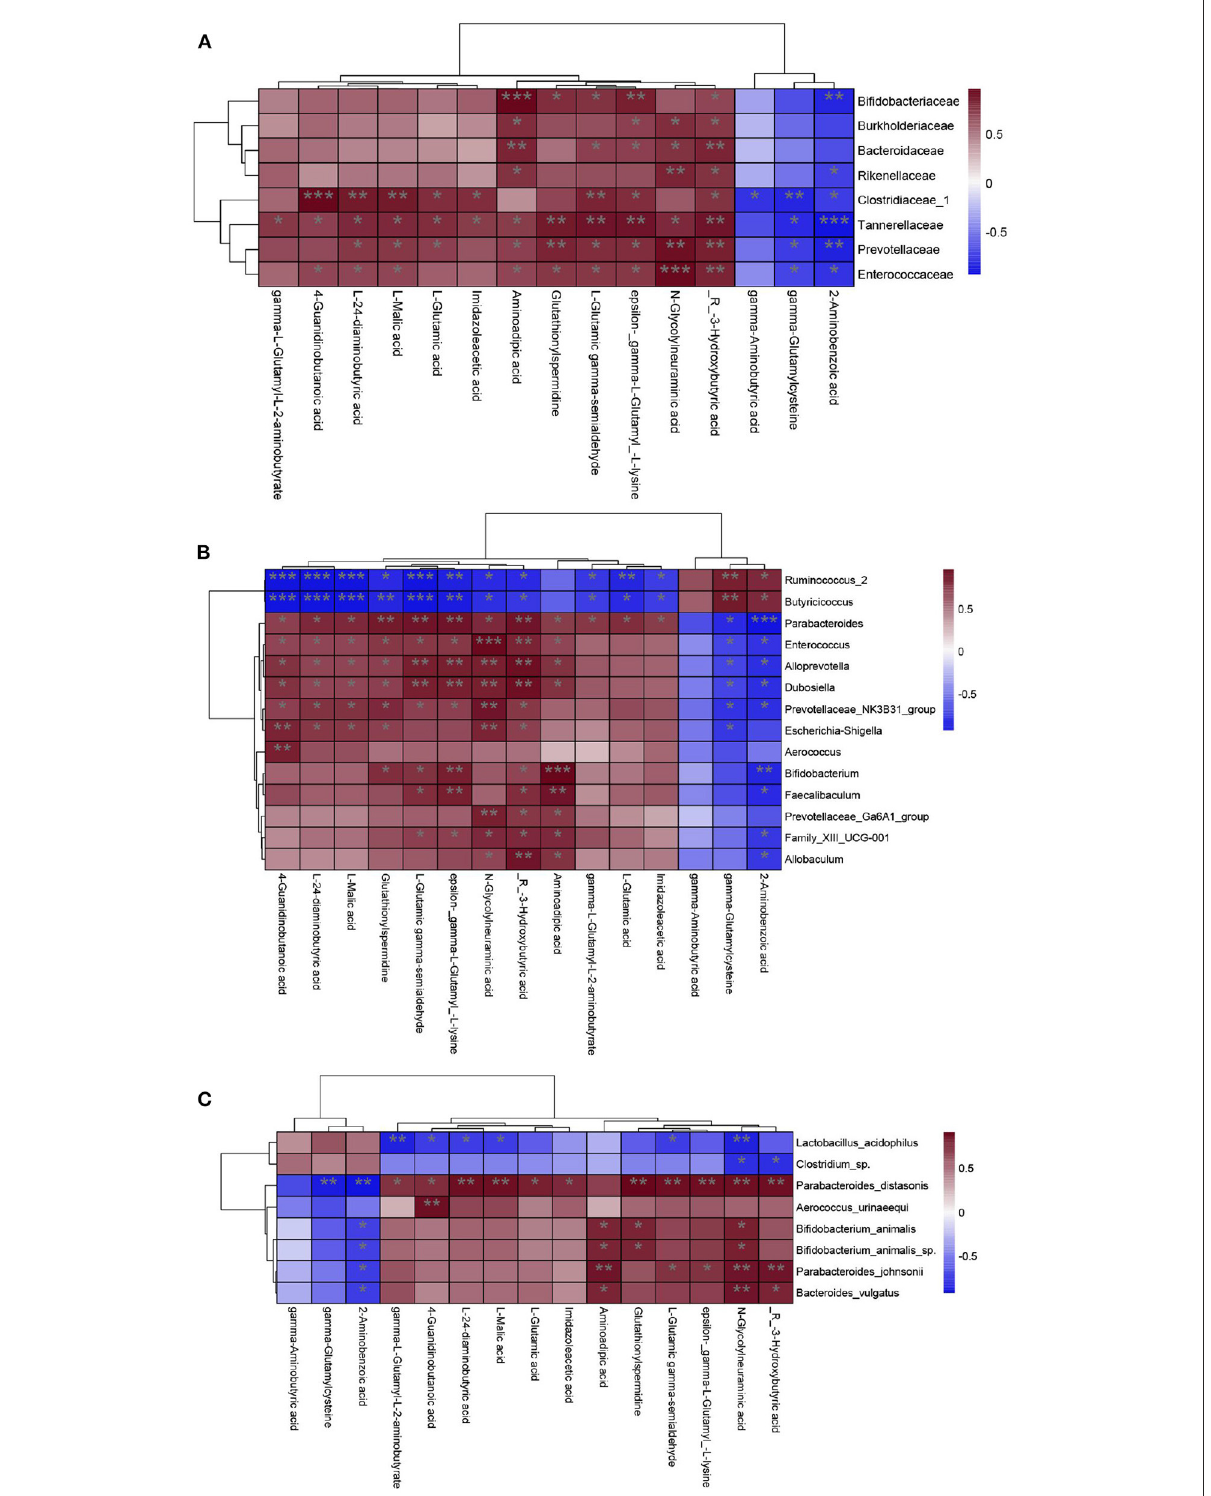
FIGURE6 Correlation analysis of gut microbiota and metabolites from family to species level. (A) Family level. (B) Genus level. (C) Species level. Heat maps indicated positive (red) and negative (blue) correlations between the dominant species and 15 differential metabolites we focus. The legend shows correlation values from − 1 to 1 and assigns the appropriate color to them (Red for positive correlations and blue for negative correlations). (A–C) * P < 0.05, ** P <